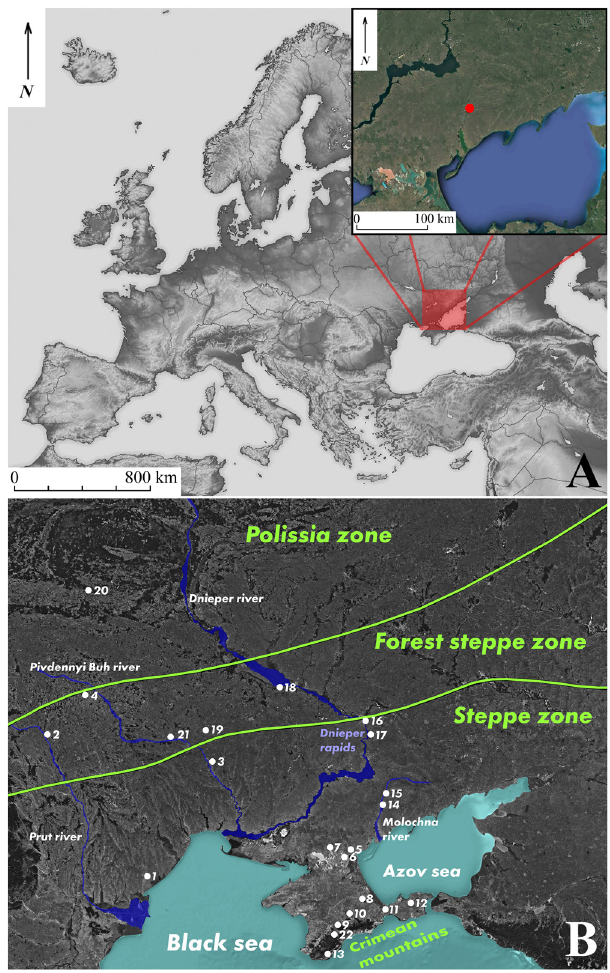
Figure 2: ( a ) Map: Situation of North Meotic region in Europe ( rectangle ) with a location of the Kamyana Mohyla 1 site ( red circle ) ( b ) Map: Sites in the south of Eastern Europe which were attributed to “ Kukrek ” sensu lato : ( 1 ) Trapivka, ( 2 ) Badragii Vechi, ( 3 ) Abuzova Balka, ( 4 ) Mykolaivka, ( 5 ) Liublinka II, ( 6 ) Vesnianka V, ( 7 ) Serhiivka I, ( 8 ) Olexiivska Zasukha, ( 9 ) Kukrek, ( 10 ) . Vyshenne 1, ( 11 ) Frontove, ( 12 ) Tasunove, ( 13 ) Balin - Kosh, ( 14 ) Kamyana Mohyla 1, ( 15 ) Prylukivka, ( 16 ) Ihren VIII, ( 17